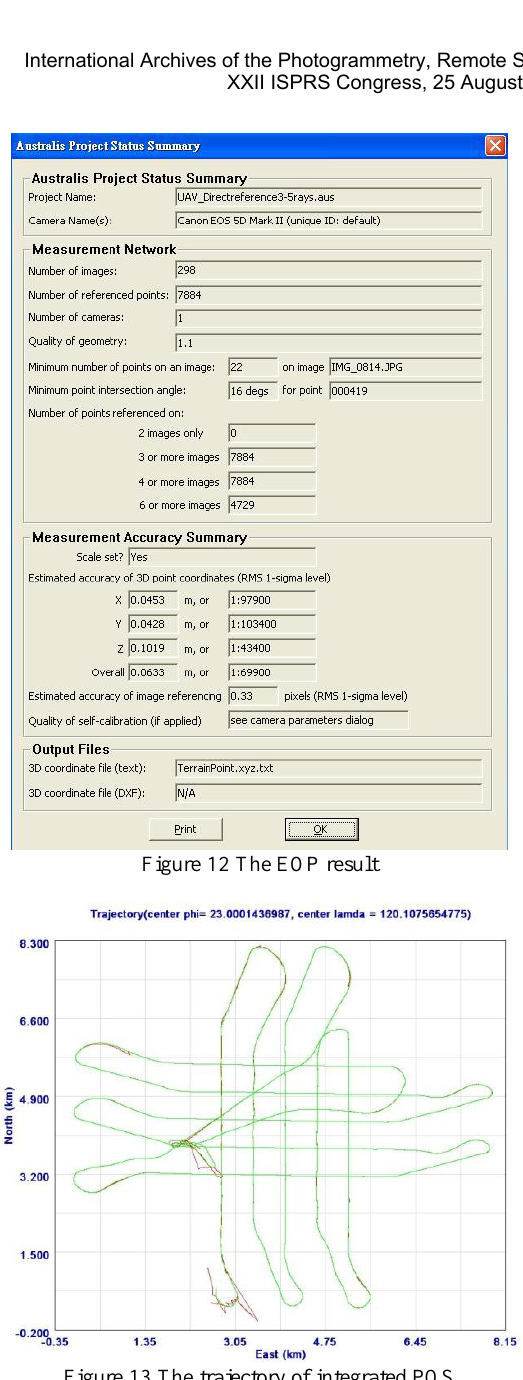
Figure 13 The trajectory of integrated POS